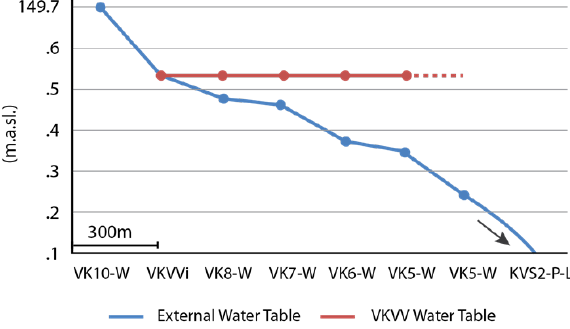
Figure 3. Water table measurements (m a.s.l.) measured in wells surrounding the wetland on 21 June 2016 are presented in blue. Surface water levels on the mire measured by FJ Loock Surveyors Inc. on 24 June are presented in red. The Y-axis corresponds to the water table and the X- axis corresponds to the straight-line distance from the southernmost measuring point VK10-W to the northernmost piezometer nest KVS2-P, which was dry throughout the observation period. The black arrow indicates that the water table at KVS2-P-L was deeper than 149.1 m